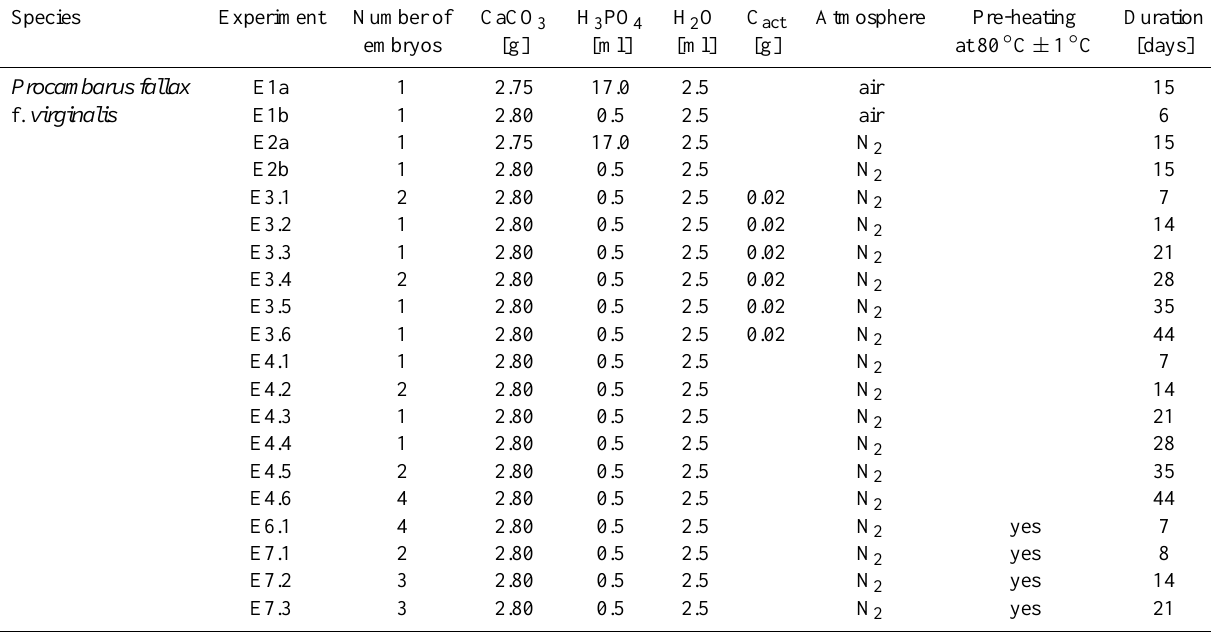
Table 1. Phosphatization experiments performed and corresponding conditions and duration. Species Experiment Number of CaCO 3 Atmosphere Pre-heating Duration embryos Procambarus fallax